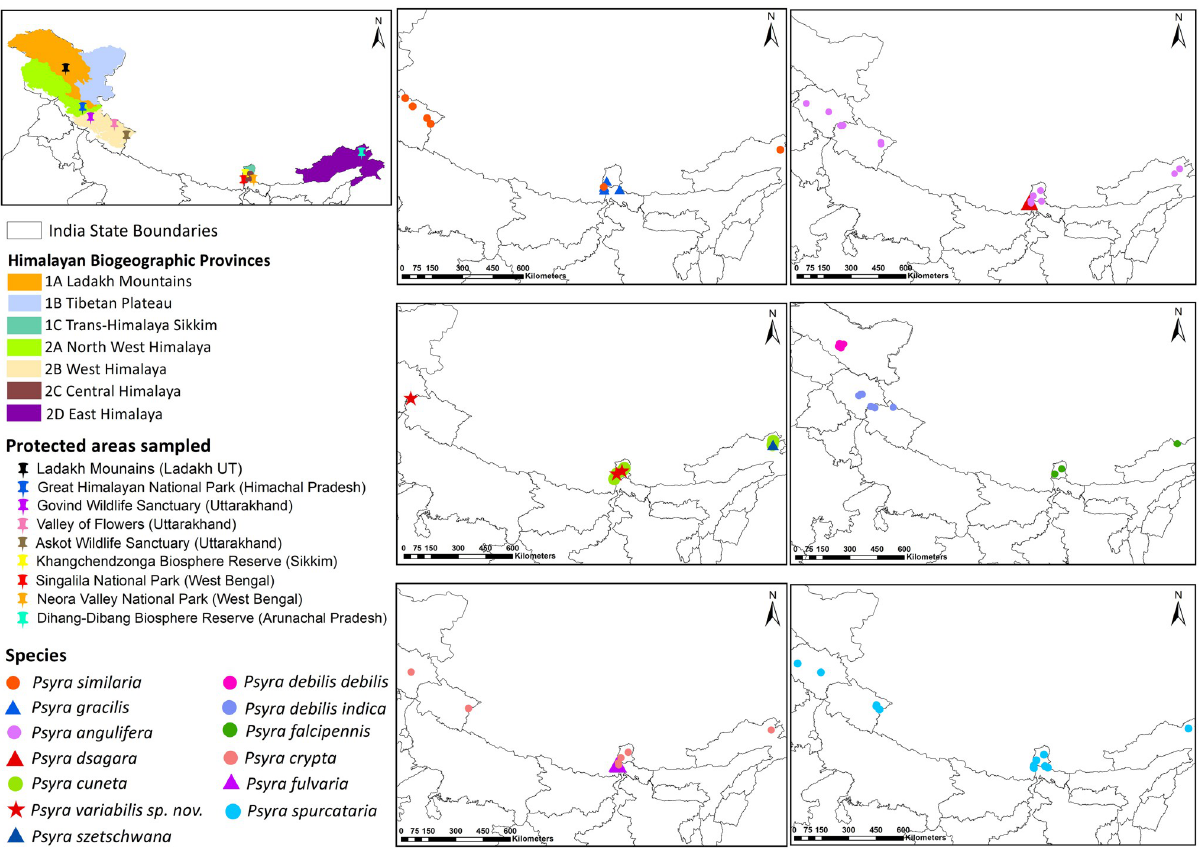
Fig 1. Collection localities of Psyra species/subspecies recorded from 5 biogeographic provinces and 9 Protected Areas in the Indian Himalaya during sampling period of 2010–2012 and 2016–2019.